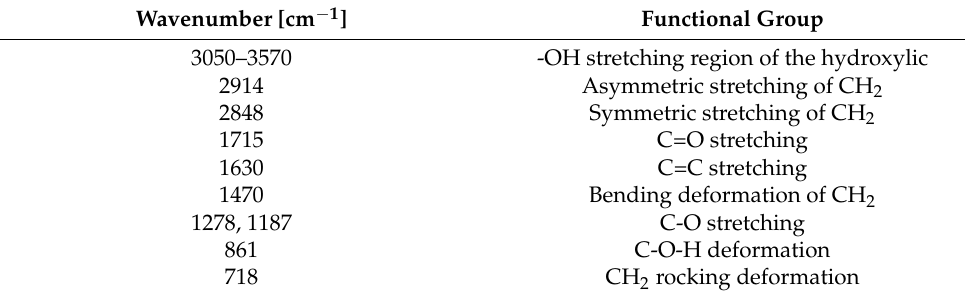
Table 1. List of band assignments for FTIR spectra.